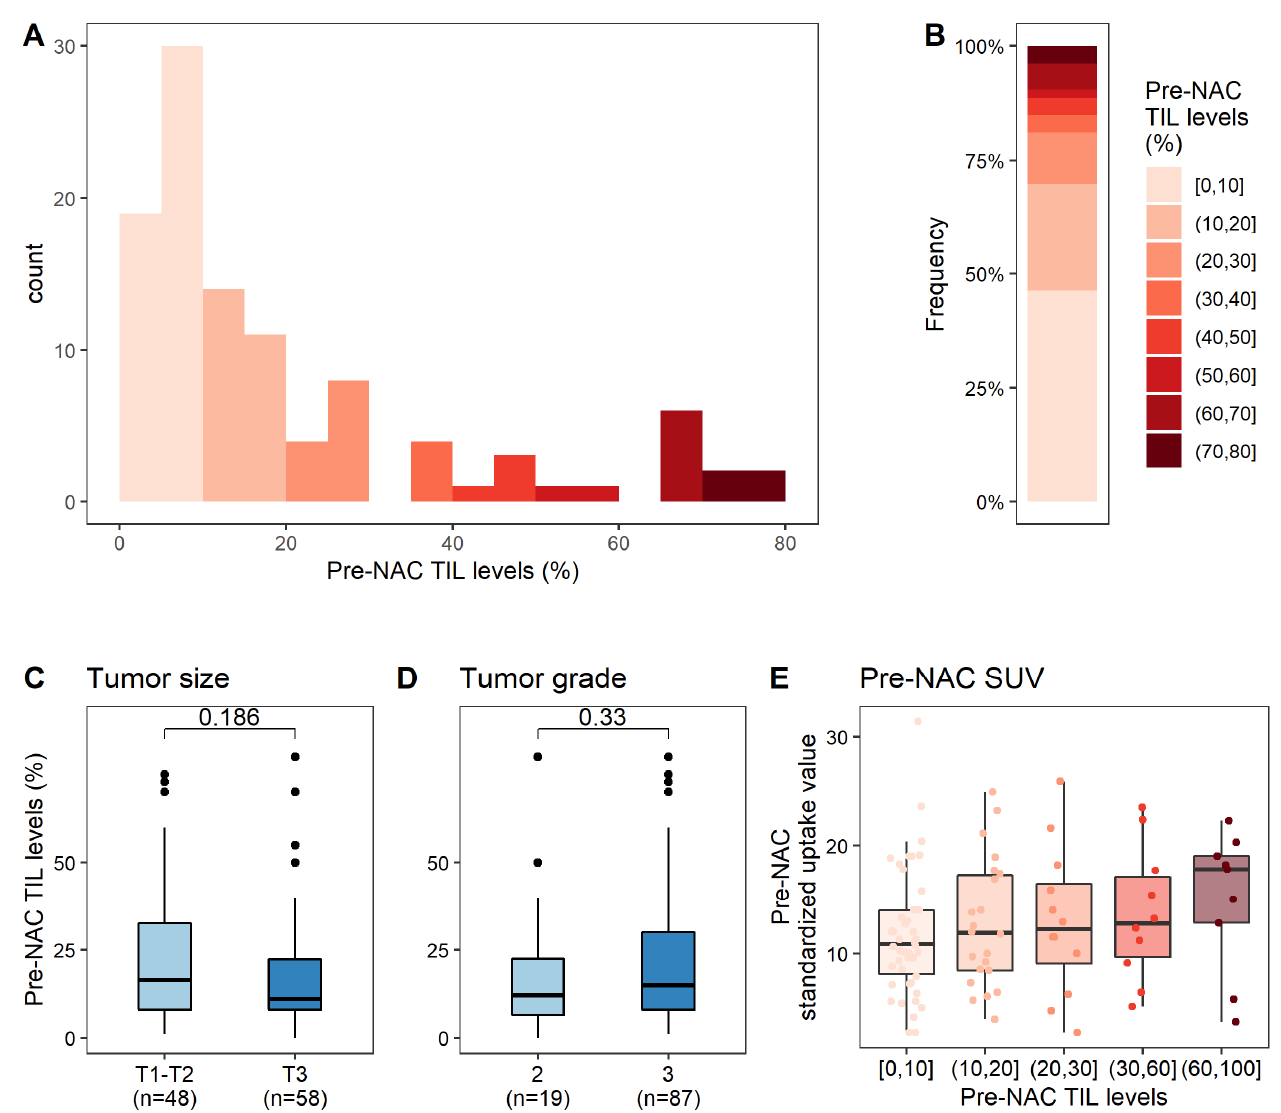
Figure 2. Associations between pre-NAC TIL levels and clinical, pathological, and metabolic factors. ( A ) Distribution of pre-NAC TIL levels; ( B ) Distribution of pre-NAC TIL levels, by increments of 10%; ( C – E ) Association of pre-NAC TIL levels with clinical and pathological factors: tumor size ( C ), tumor grade ( D ), pre-NAC SUV ( E ).